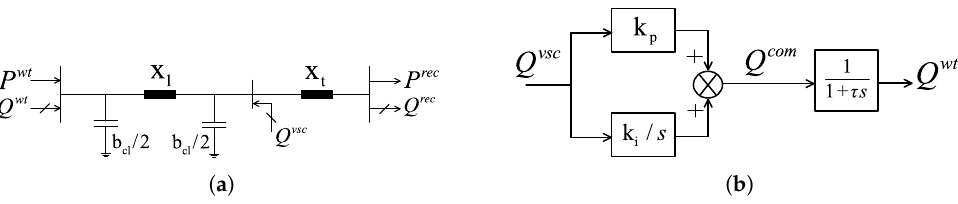
Figure 6. Voltage source converter (VSC) power rating analysis: ( a ) simplification of the considered OWF for the VSC power rating analysis; ( b ) wind turbine (WT) reactive power control